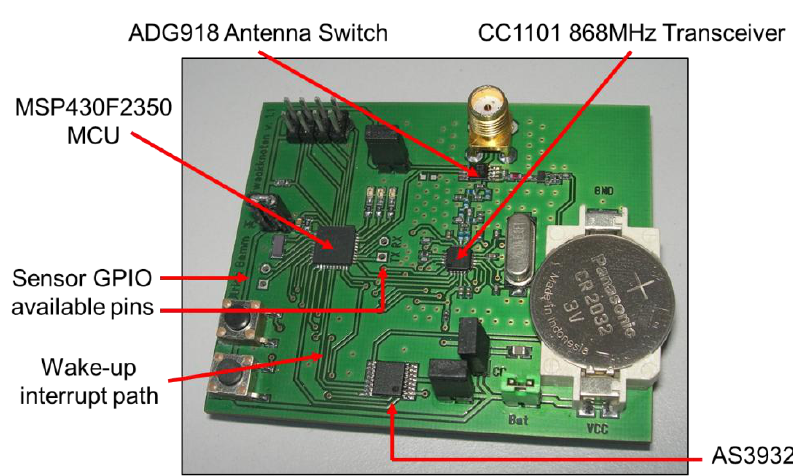
Figure 4. The SCM-WuR hardware